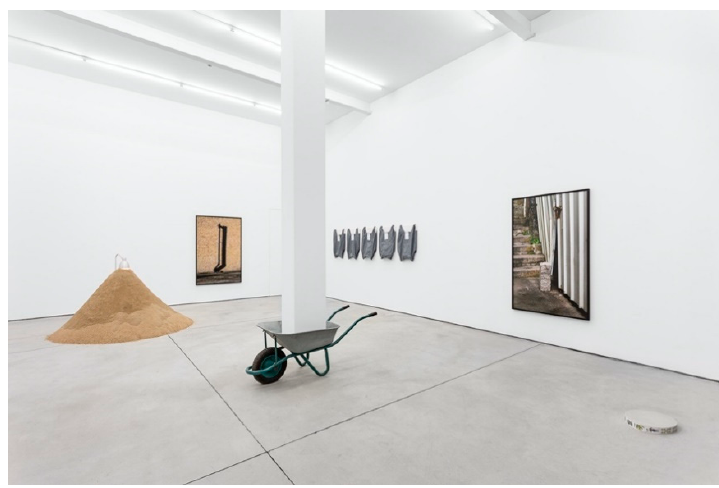
Figure 3. Distorção Inerente. First exhibition at Bruno Múrias, 2018. © Bruno Múrias. Figure 3. Distorç ã o Inerente. First exhibition at Bruno M ú rias, 2018. © Bruno M ú rias.